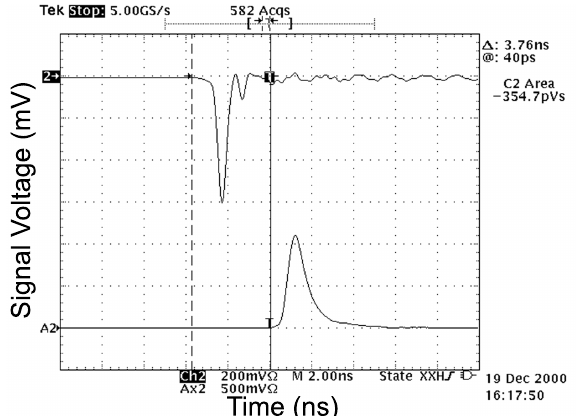
FIG. 11. Faraday cup measurements of dark current. The up- per trace is the dark current signal with a cathode gradient of 125 MeV (cid:1) m, showing a current of (cid:2) 70 m A, and the lower trace is the power in the full cell of the gun. The horizontal scale is 100 ns (cid:1) div, and the vertical scale is 2 mV (cid:1) div for the upper trace and 20 mV (cid:1) div for the lower trace.